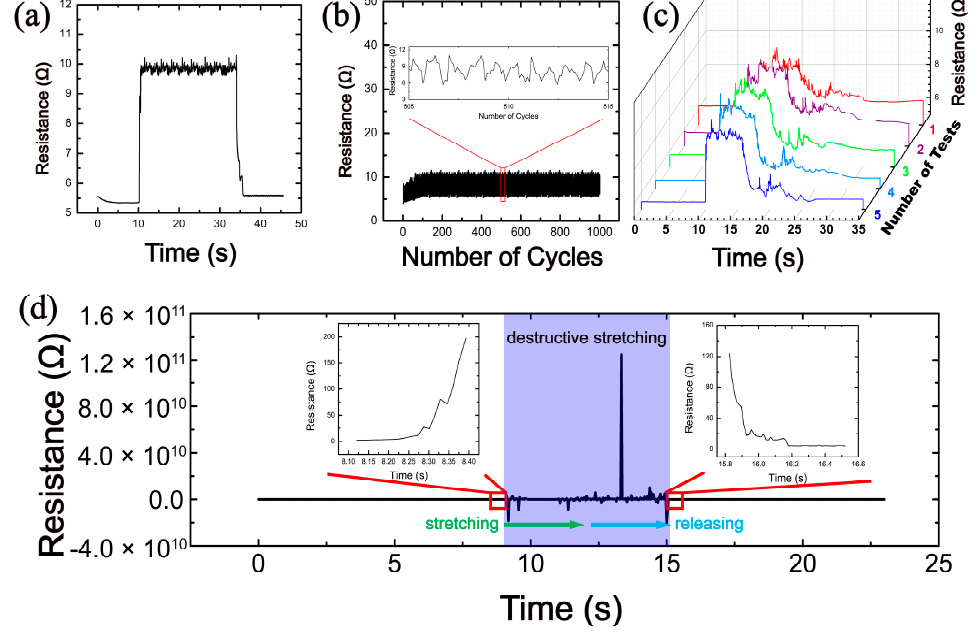
Figure 5. Conductive stability tests of the optimal electrode with a mass ratio of silver glue to PDMS of 1:0.4 during stretching process. Under a strain of 20%, ( a ) sustained stretching test, ( b ) 1000 times cyclic stretching test, and ( c ) intermittent stretching test. ( d ) Destructive stretching-releasing test under a strain of 200%.